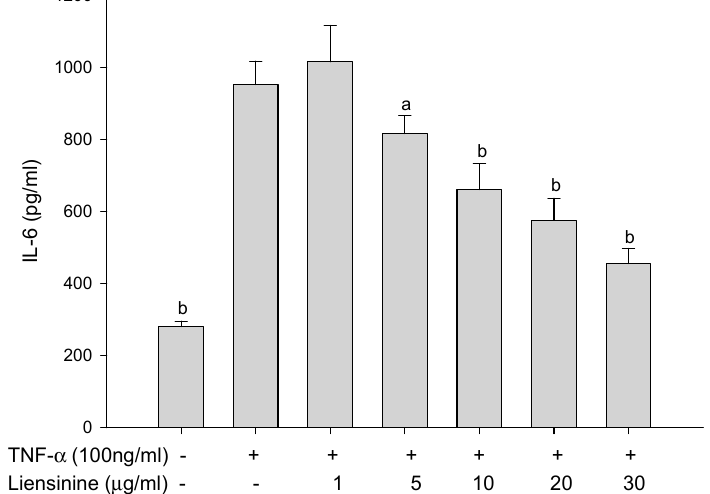
Figure 5. The effect of liensinine in IL-6 release in TNF- α stimulated VSMC. VSMC were pretreated with different concentrations of liensinine and stimulated with TNF- α . The effect of liensinine on IL-6 release was measured by IL-6 ELISA Kit. Liensinine concentration-dependently inhibited the IL-6 release in VSMC. a p < 0.05 and b p < 0.01 vs. Control (only TNF- α ). n = 3 replicates.